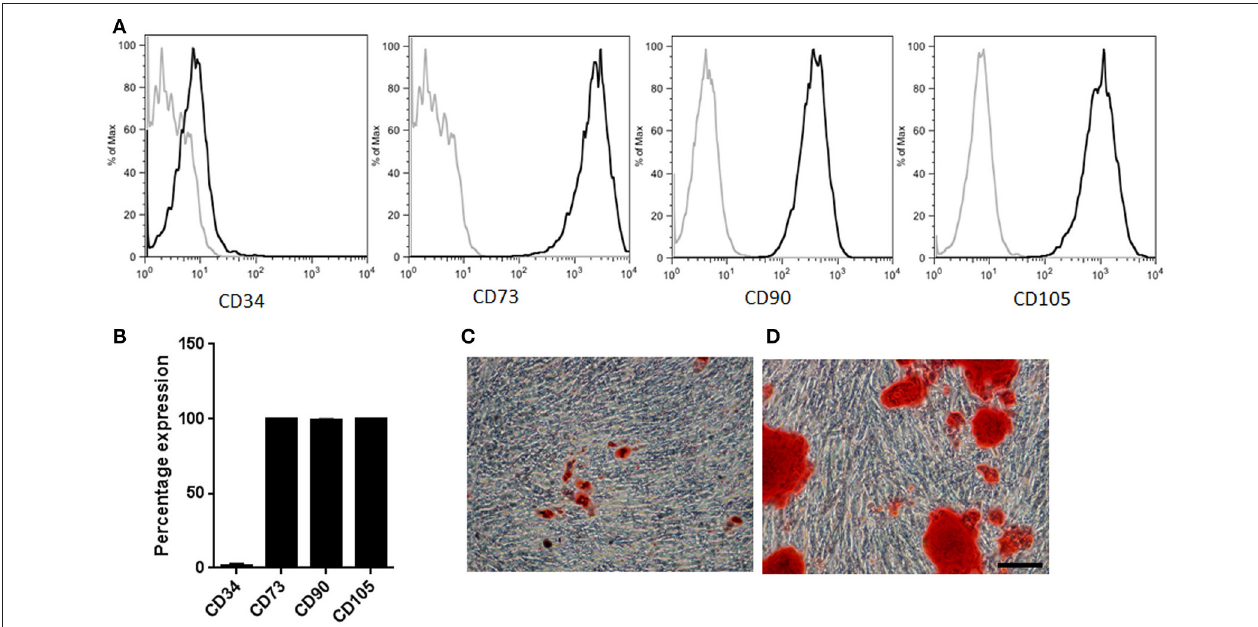
FIGURE 1 | MSCs characterization. (A) Representative sample illustrating immunophenotypic profile. Antibodies against CD34, CD73, CD90, and CD105 (thick gray lines) with isotype control (thin gray lines). (B) Percentage expression corresponding to the average profile of all cell types ( n = 3). (C) Representative sample of MSCs induced into adipogenic lineage differentiation. Neutral fat lipid droplets were detected by Oil red O stain (D) Representative sample of MSCs induced into osteogenic differentiation. Extracellular calcium deposits were determined by Alizarin Red stain. Scale bar 100 µ